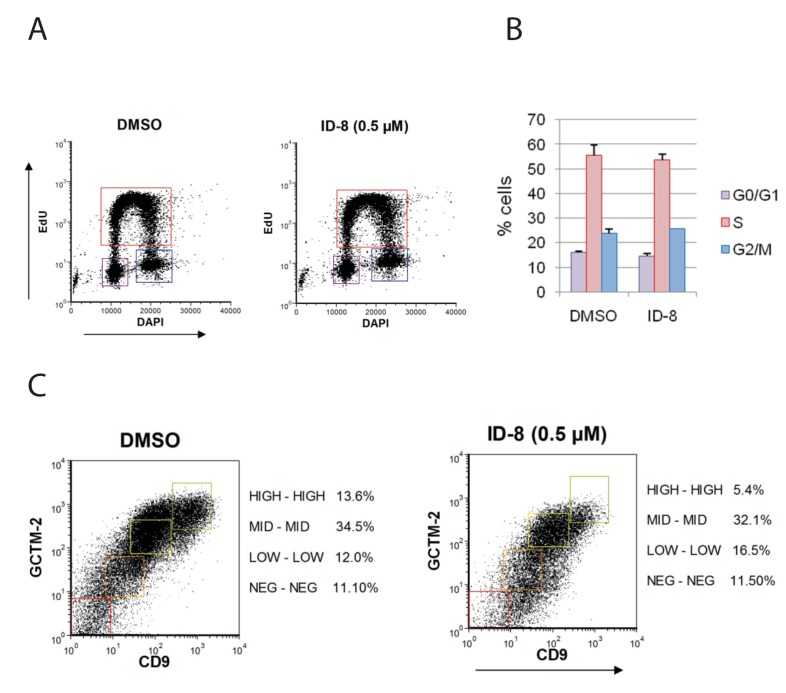
ID-8 treatment does not interfere with hESC proliferation or alter expression of stem cell markers under conditions that promote self-renewal.(A) flow cytometry profiles of control and ID-8 treated cells following incubation with a pulse of Edu. (B) proportion of cells in GO/G1, S, and G2/M phases in control or ID-8 treated cultures; (C) ID-8 treatment does not alter proportion of cells bearing hESC stem cell surface markers. Dual label flow cytometry profiles for stem cell antigens GCTM-2 and CD9 in control and. ID-8 treated cells.